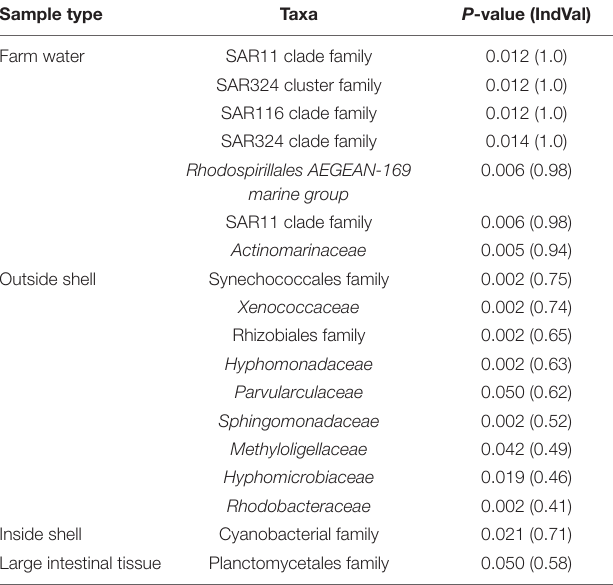
TABLE 1 | Indicator species analysis showing bacterial taxa at family level which were significantly associated with different oyster tissue types or farm water. Sample type